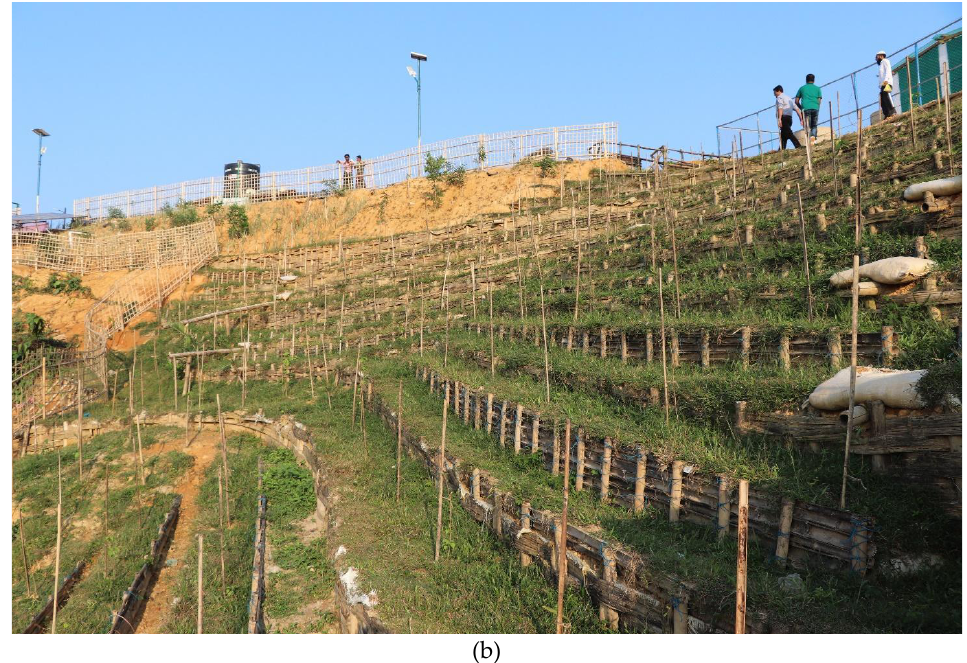
Figure 4. Schematic technical specification ( a ) and on-the-ground implementation of land stabilization activity ( b ) using multiple vegetation layers to reduce the risk of rainfall-induced landslides and